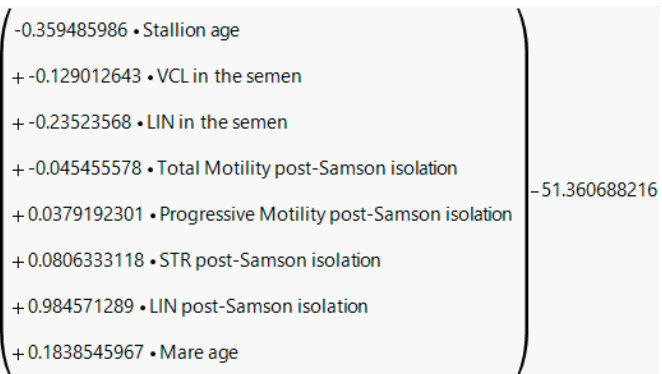
Figure A8. Equation optimized for stallion 2 from the post-chilled data set: predictive accuracy of 100%.